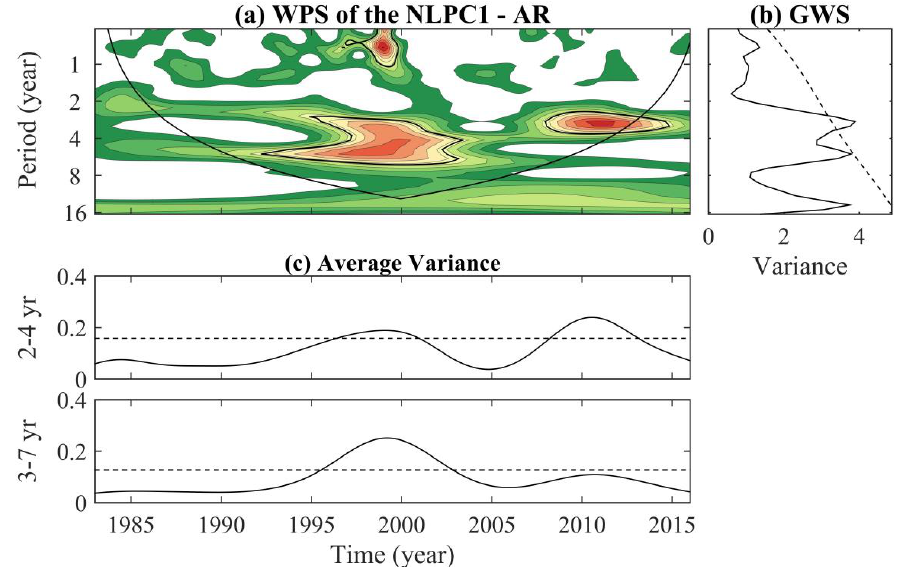
Figure 8. ( a ) Wavelet power spectrum (WPS) of NLPC1-AR. The closed contours encompass significant variations with confidence levels of 95%; Under the U-shaped curve, the region where the edge effects are important can be noted; ( b ) Global Wavelet Spectrum (GWS); and, ( c ) 2–4- and 3–7- year Scales-Averaged Power (SAP) of the time series.